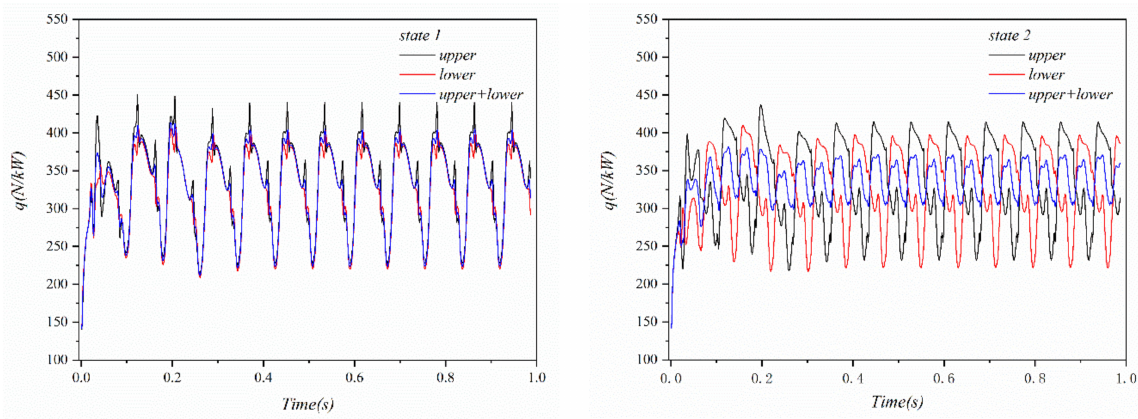
Figure 17. The isolated rotor C Q of the upper and lower rotors in forward flight.